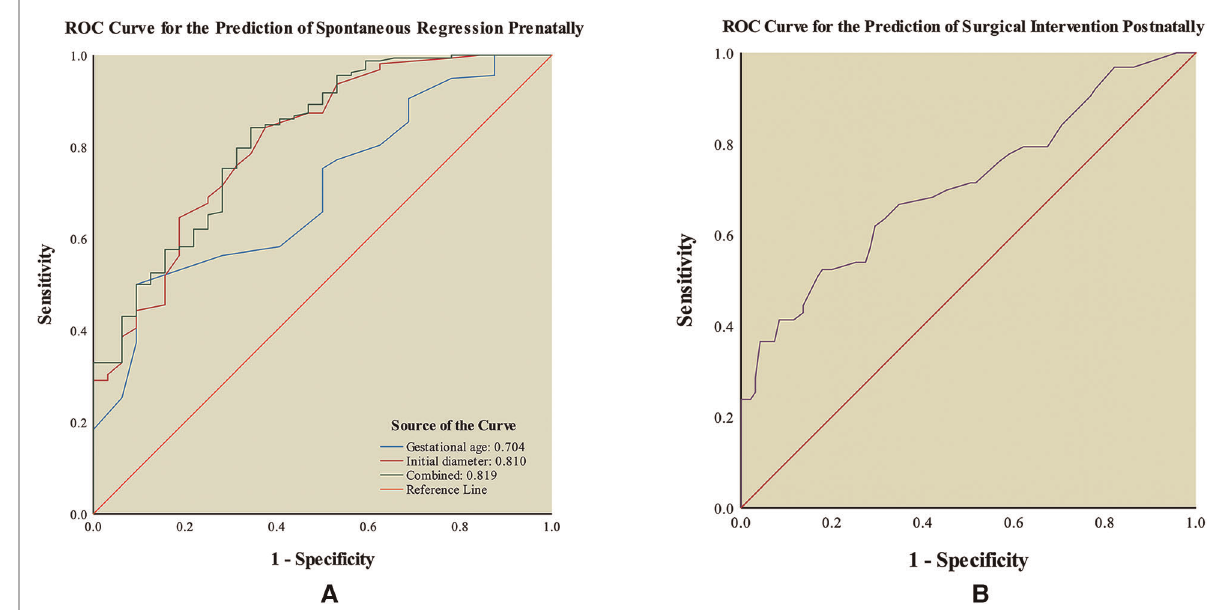
FIGURE 2 Receiver operating characteristic (ROC) curve of outcomes of fetal intra-abdominal cystic lesions. ( A ) ROC curve for the prediction of spontaneous regression prenatally. ( B ) ROC curve for the prediction of surgical intervention